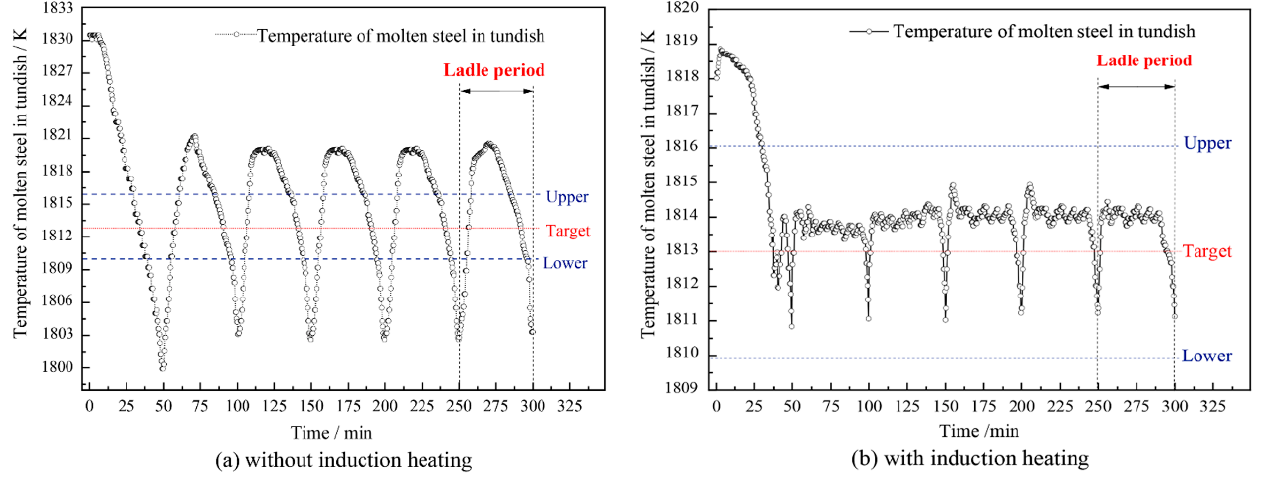
Figure 10. Molten steel temperature in tundish without ( a ) and with ( b ) IH [26]. IHT with a splayed channel has the advantages of non-contact heating, good respon- siveness, high heating efficiency, good purification effect of molten steel, good automatic control, and easy installation and maintenance. The splayed channel IHT has been suc- cessively used in steel plants. The industrial test results showed that the metallurgical results were satisfactory. The temperature drop of molten steel in tundish during the whole casting process was studied by using continuous temperature measurements and induction heating. It was found that the temperature drop rates at the end of the second and third furnaces in the middle of the pouring furnaces were relatively high. The target superheat can be controlled within the range of 15~20 ◦ C, adopting induction heating technology to compensate for the tundish